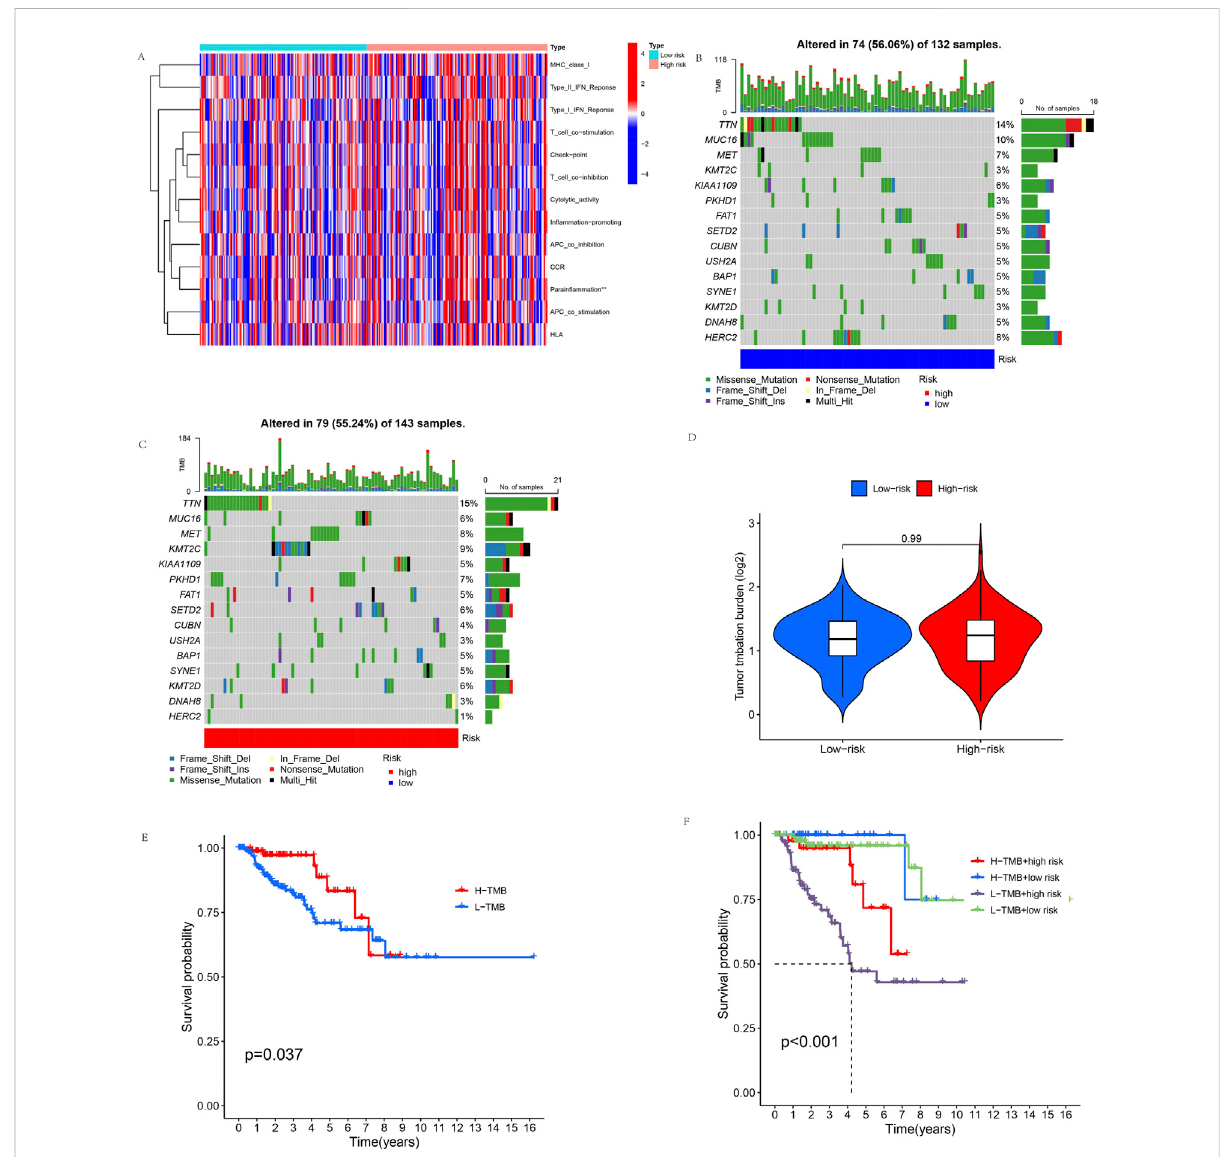
FIGURE 9 Immune-related function analysis and TMB. (A) Immune-related functions of the 11 cuproptosis-related lncRNAs. (B,C) These waterfall plots show somatic mutations of the most signi fi cant 15 genes among (B) low-risk and (C) high-risk KIRP patients. (D) Differential TMB in high-risk and low-risk groups in KIRP. (E) Survival curves for the high-TMB and low-TMB groups in KIRP. (F) The combined TMB-risk survival curve. (* p < 0.05, ** p < 0.01,*** p < 0.001, asterisks (*) stand for signi fi cance